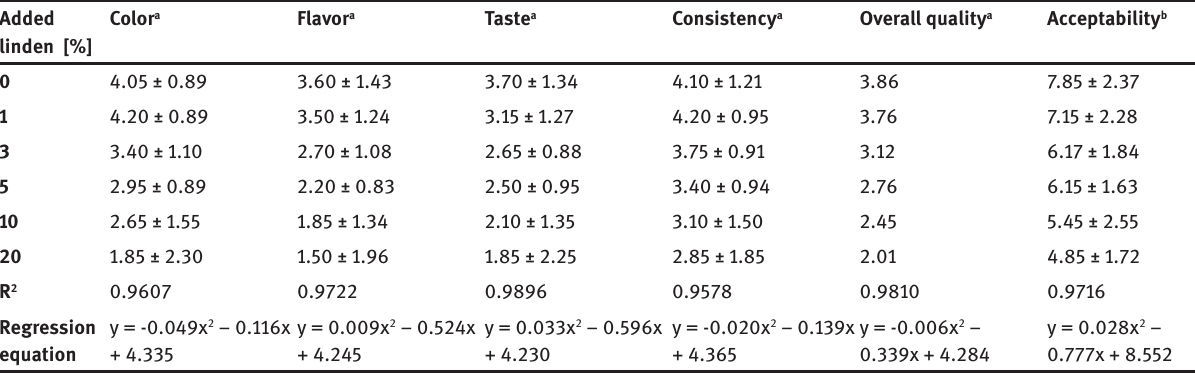
Table 6 : Sensory assessment and acceptance results for corn gruels enriched with linden flower.